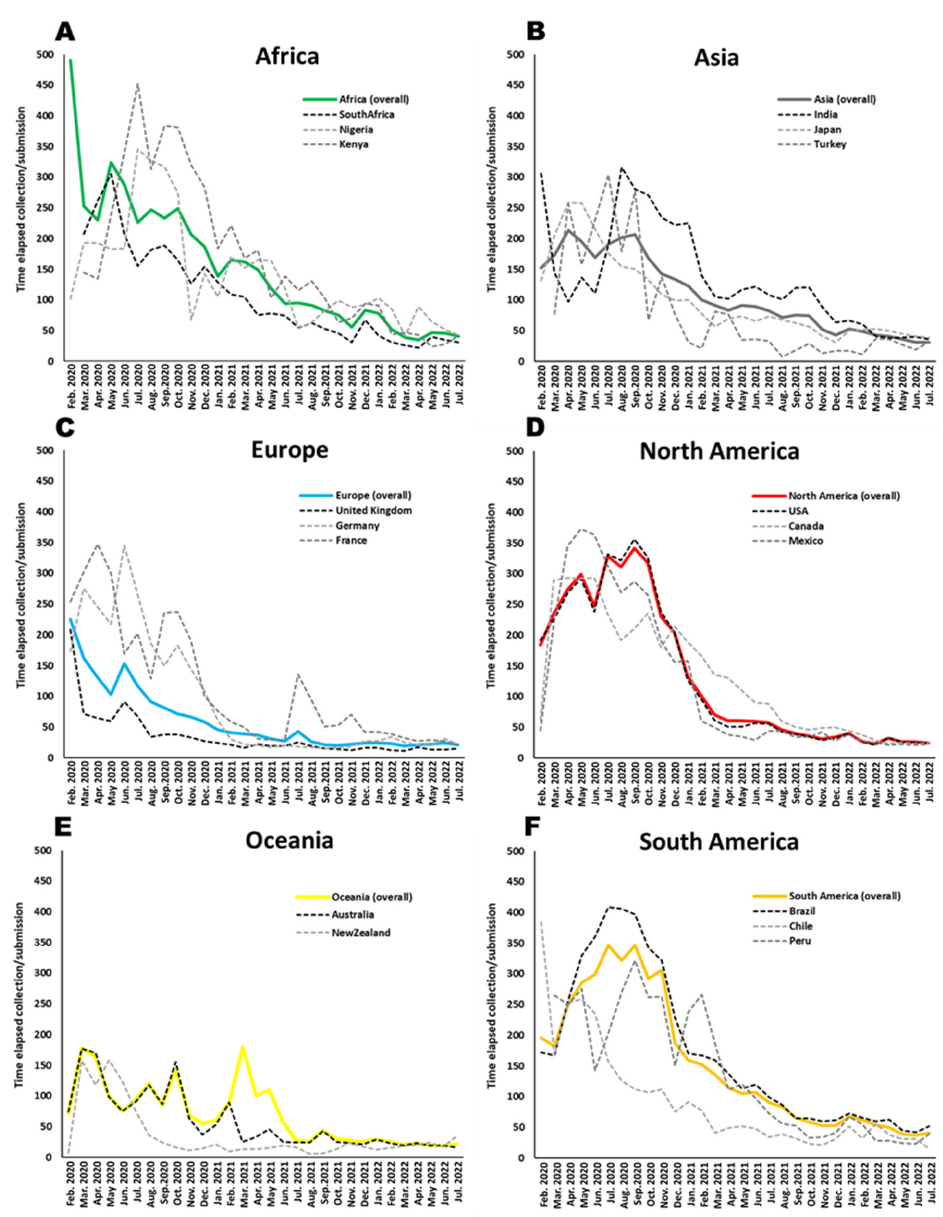
Figure 3. Estimated time elapsed between SARS-CoV-2 isolate collection and the deposit of the genome in the GISAID dataset for each continent; (( A ) Africa, ( B ) Asia, ( C ) Europe, ( D ) North America, ( E ) Oceania, and ( F ) South America), between February 2020 and July 2022.